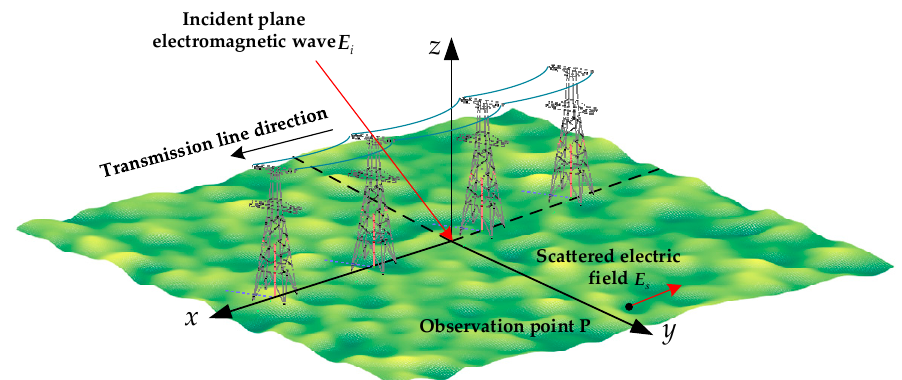
Figure 1. Calculation Model of passive interference of UHV transmission line.